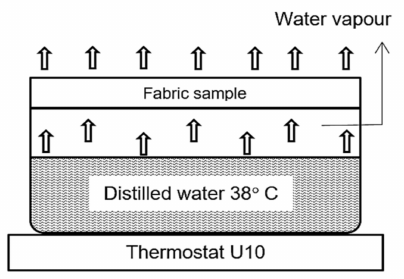
Figure 5. Water vapor permeability test (“cup”